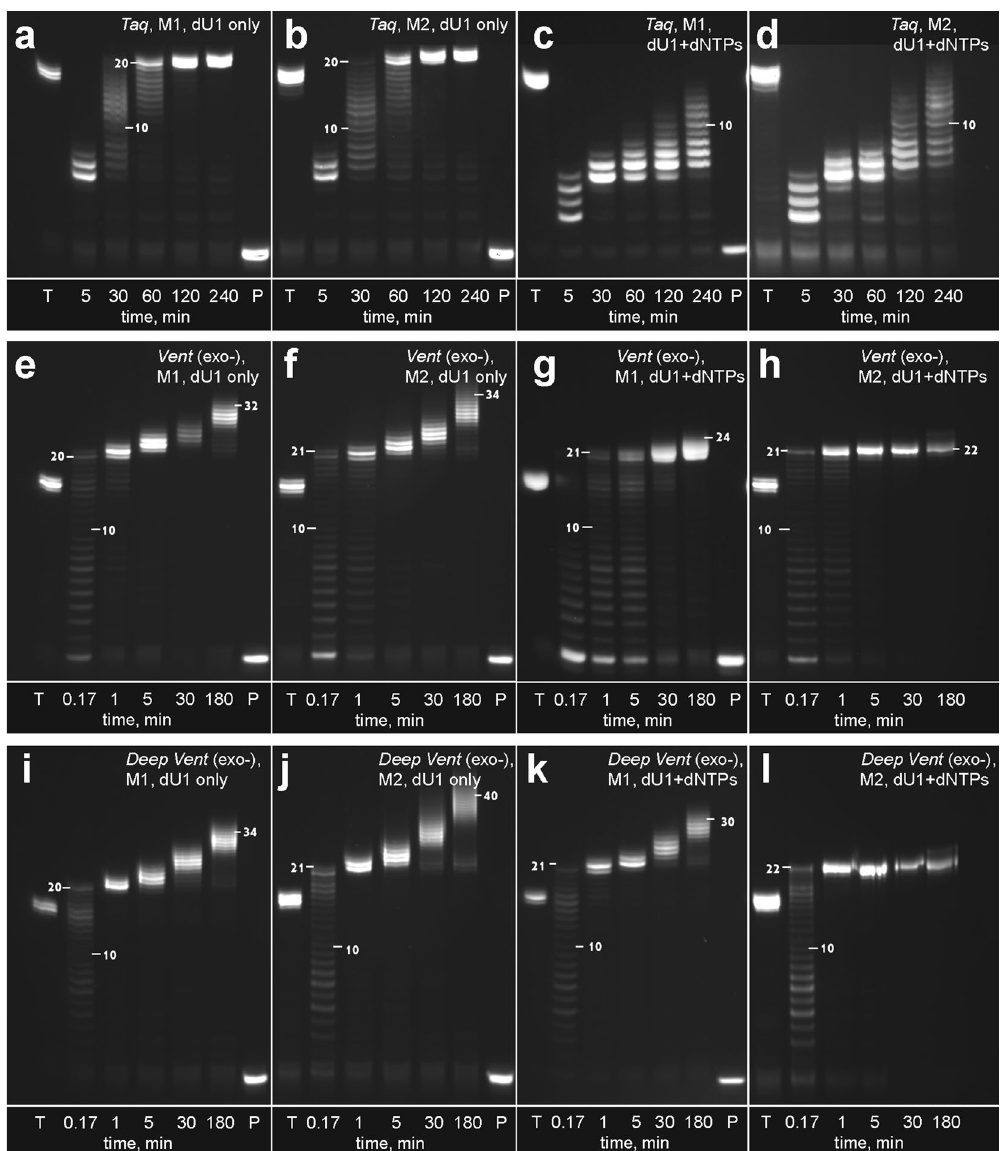
polymerases. Lane T: TTP/Taq polymerase, 1 h. Lane P: primer. The abbreviation “dNTPs” here means a mixture of dATP, dCTP and dGTP. The numbers indicate the difference in the length between the selected fragment and the primer. Source gel images are presented in Supplementary Figure